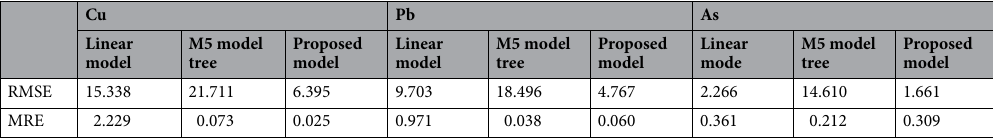
Table 6. Comparison of the estimation errors for Cu, Pb, and As based on three models.